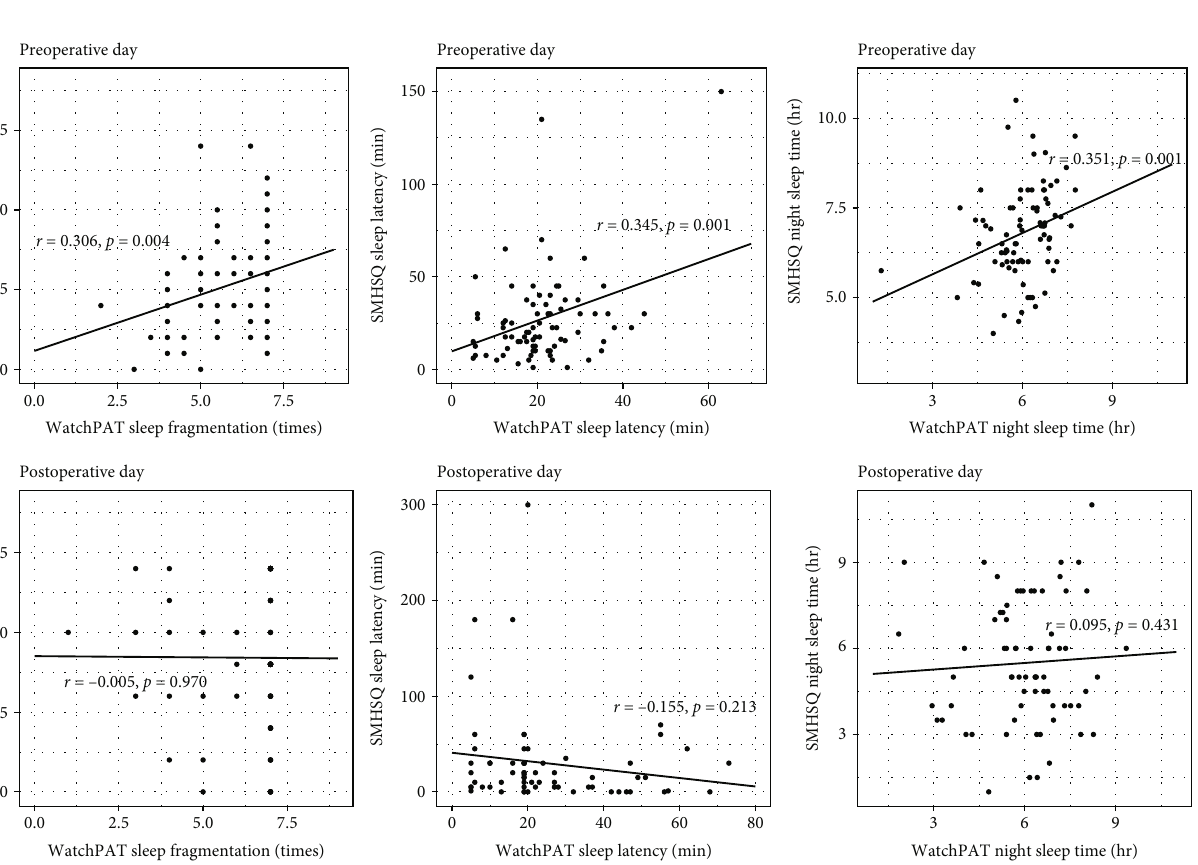
Figure 2: Scatter plots of sleep fragmentation, sleep latency, and total night sleep before and after surgery. r : Pearson ’ s correlation; SMHSQ: St. Mary ’ s Hospital Sleep